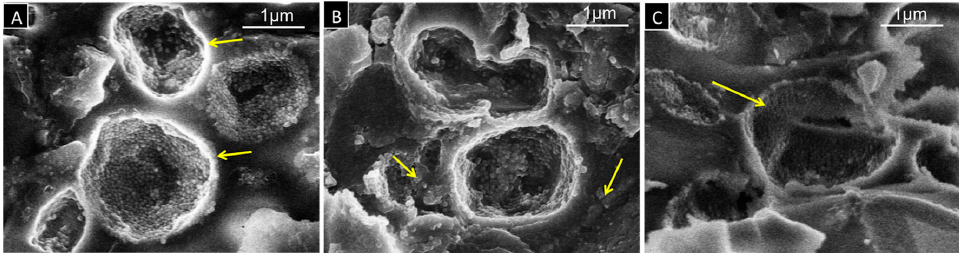
Figure 6. SEM images at 20,000× magnification of modified cement, representing the structural changes after treatment at: ( A ) 37 °C showing spherically shaped intact capsules filled with wax (yellow arrows); ( B ) 50 °C with capsules filled with a less amount of wax and grain-like wax structures outside the capsules (yellow arrows); ( C ) 60 °C with broken empty capsules (yellow arrow).